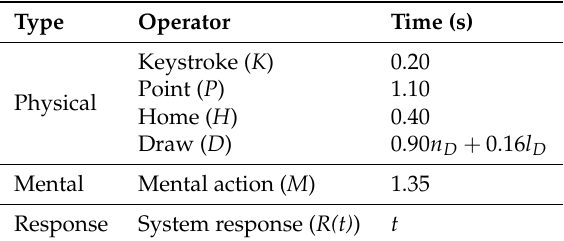
Table 1. KLM operators and unit times in seconds [27]. n D is the number of straight line segments drawn with a total length of l D